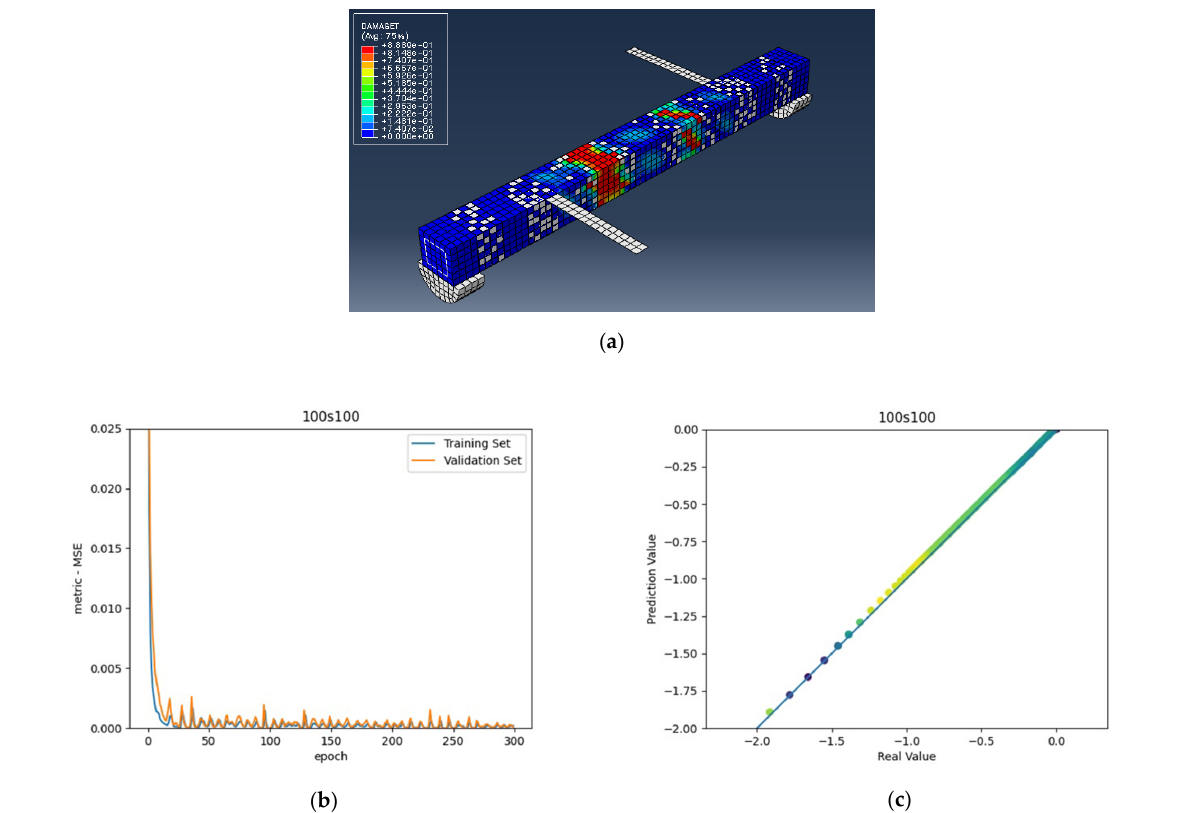
Figure 7. ( a ) FL beam under combined torsion and bending, ( b ) Training loss, ( c ) Accuracy.